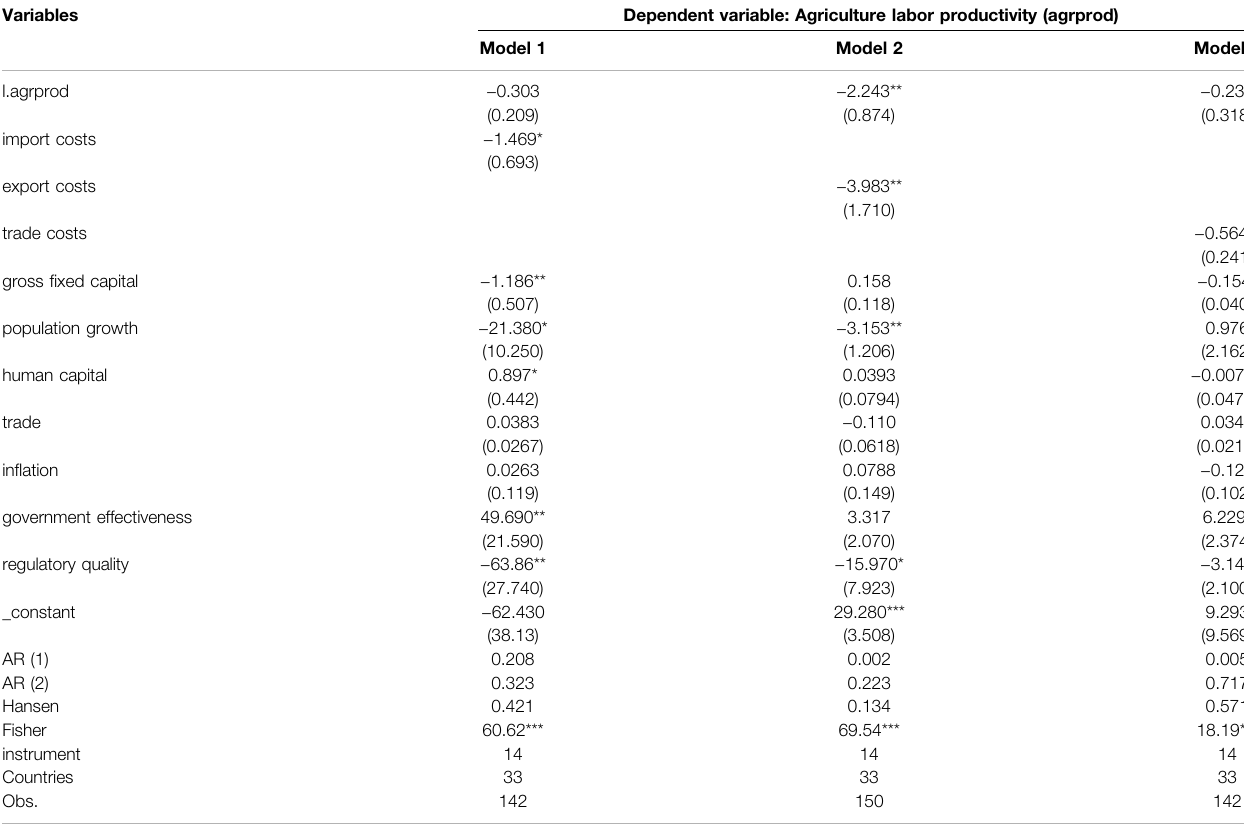
TABLE 9 | Robustness check using labor productivity for the calculation of the agriculture value-added.